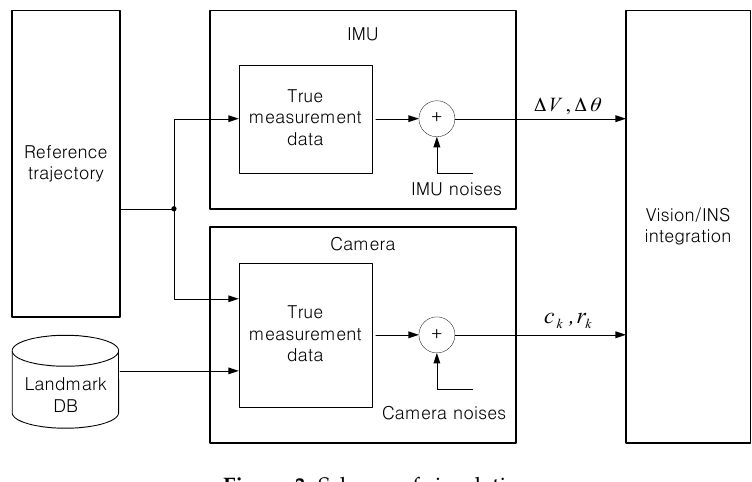
Figure 3. Scheme of simulation. Table 1. IMU specification and INS initial attitude error for simulation.